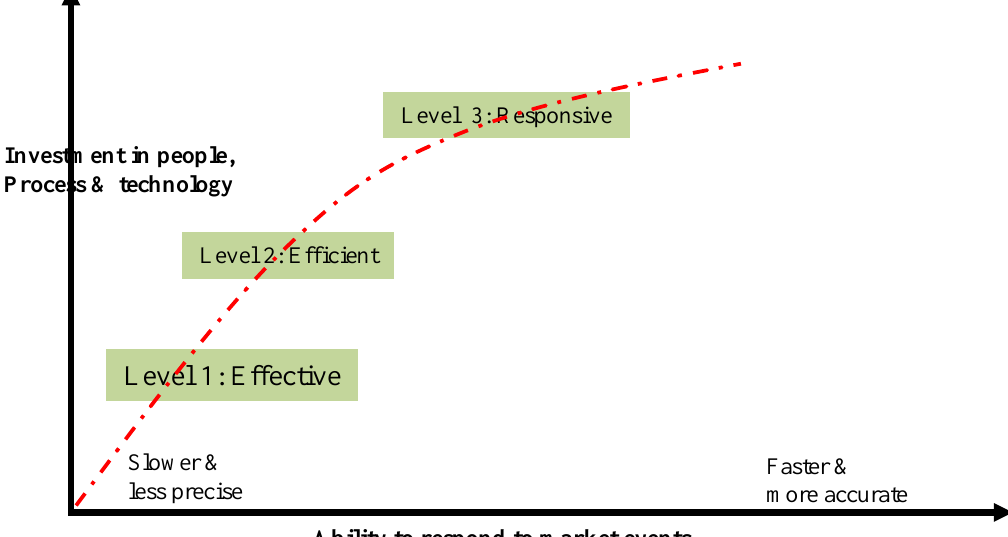
Fig. 3. Correlation among effective, efficient and responsive strategy of SCM (Brant et al.,